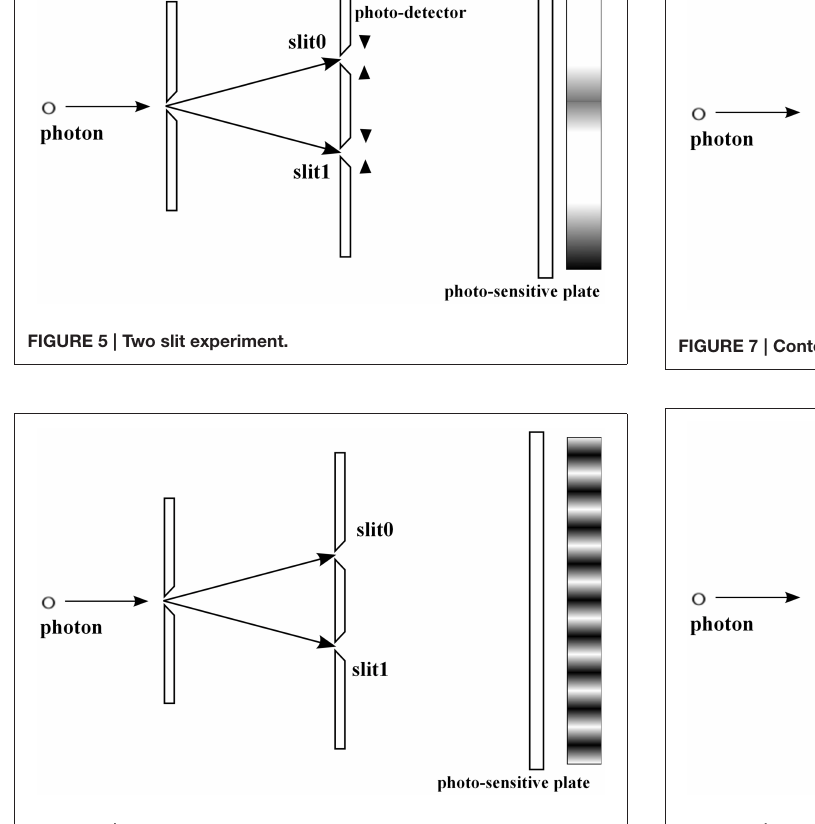
FIGURE 8 | Context with only slit0 is